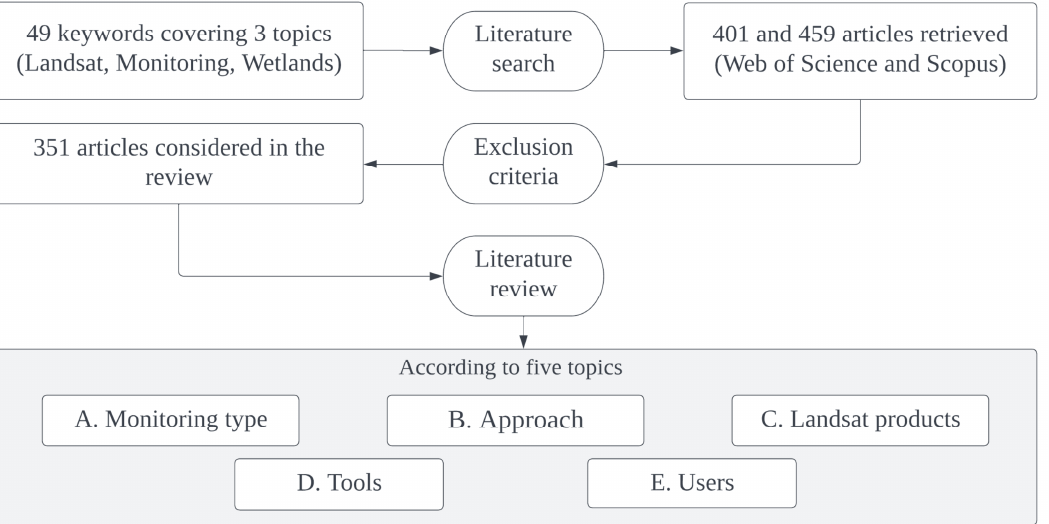
Figure 1. Flowchart used to search and review the literature on Landsat, monitoring, and wetlands (time span: 2009–2022).